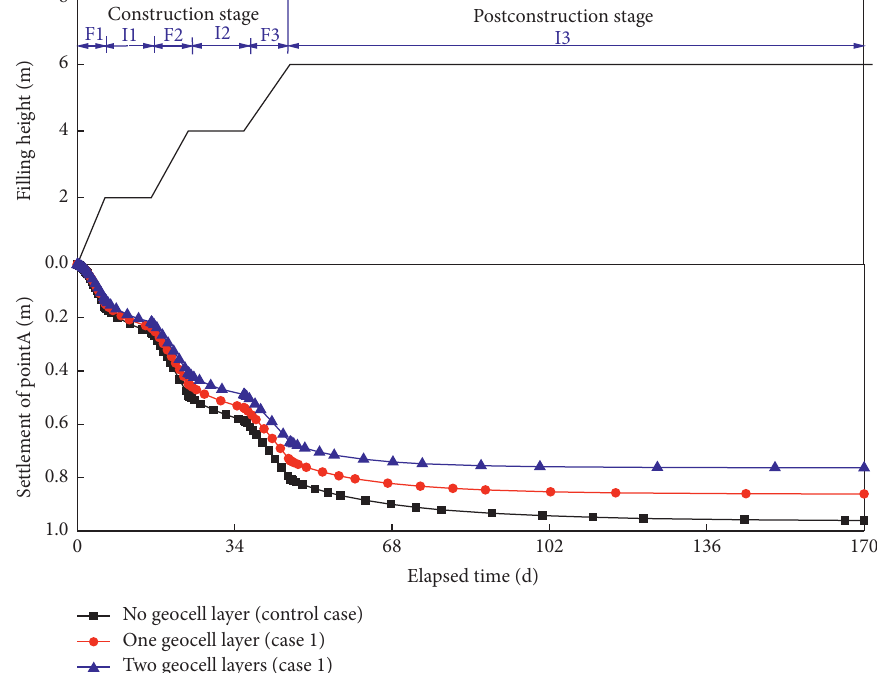
Figure 5: Influence of geocell layer in sand cushion on the settlement of point